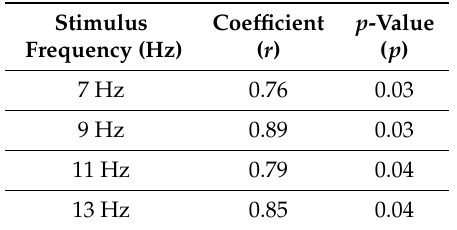
Table 2. Pearson’s correlation coefficient (N =